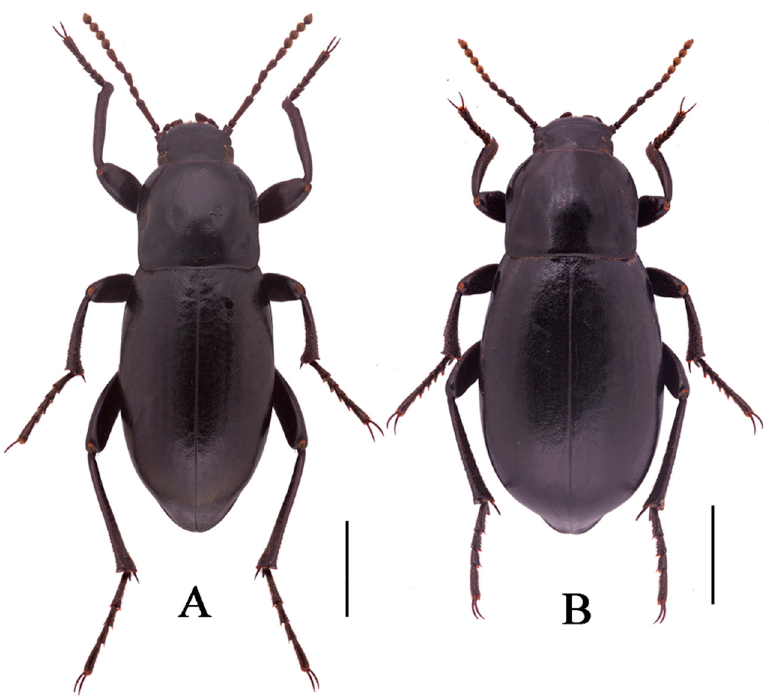
Figure 15. Nalepa ovalifolia sp. n. ( A ). head, dorsal view; ( B ). head, ventral view; ( C ). antenna; ( D ). pronotum; ( E ). protibia; ( F ). mesotibia; ( G ). protarsus; ( H ). mesotarsus; ( I ). metatarsus; ( J ). profem- ora; ( K – M ). aedeagus: ( K ). dorsal view; ( L ). ventral view; ( M ). lateral view. Scale bars: 1.0 mm.